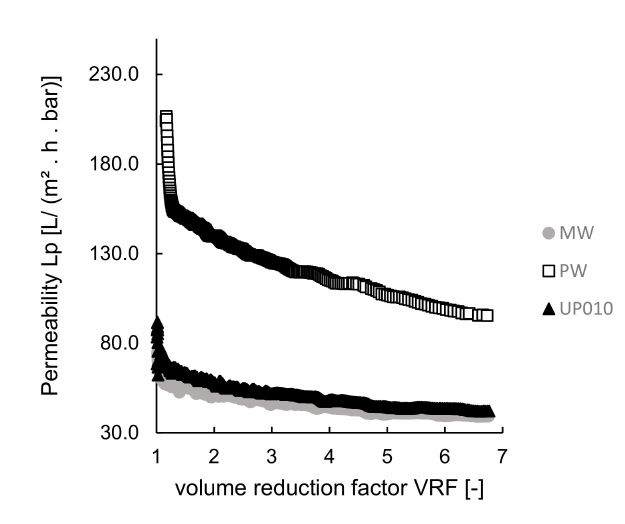
Figure 3. Ultrafiltration experiments at room temperature using various membranes: permeabilities plotted as a function of the volume reduction factor, VRF.